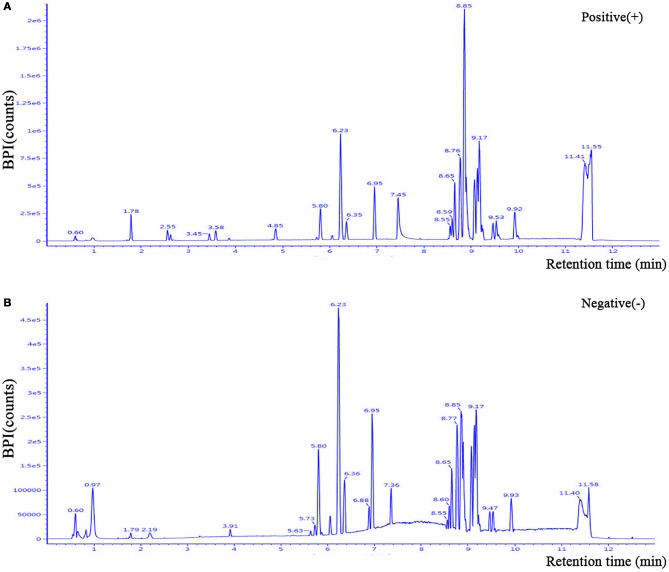
Representative LC-MS positive (A) and negative (B) ions of current chromatograms of plasma in a patient with PDD. LC-MS, liquid chromatography-mass spectrometry.